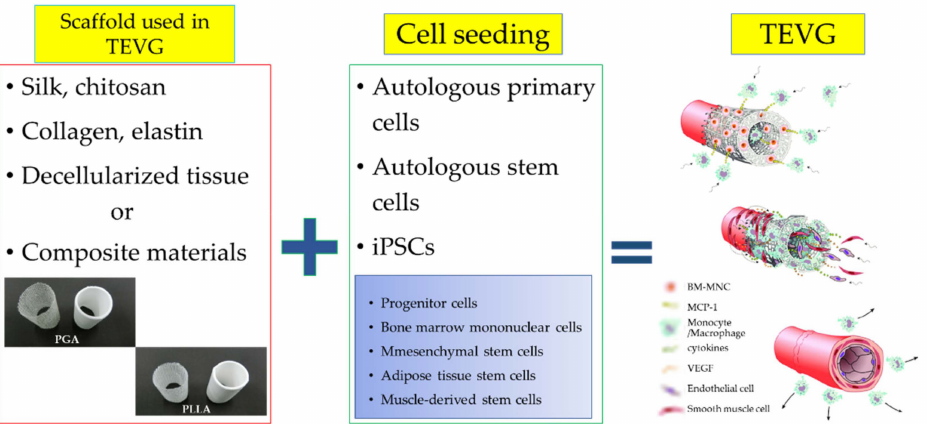
Figure 3. Progressive remodeling in TEVGs in which cells were seeded on scaffold material. It was produced by the authors using the photos provided by Gunze Ltd. (Tokyo,